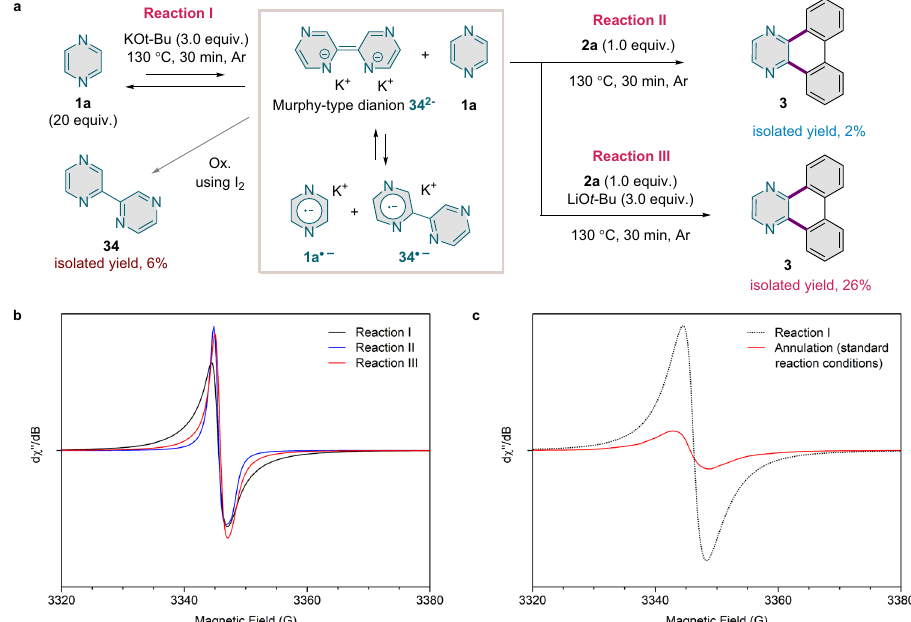
Fig. 4 EPR spectroscopic studies. a Experiments illustrating the dual role of KO t -Bu. b EPR spectra (X-band, 295 K) of samples from the reaction of 1a with KO t -Bu (reaction I; solid black line), from the two-step reaction of 1a with KO t -Bu and then with 2a (reaction II; solid blue line), and from the two-step reaction of 1a with KO t -Bu and then with 2a and LiO t -Bu (reaction III; solid red line). c EPR spectra (X-band, 295 K) of samples from the reaction of 1a with KO t -Bu (reaction I; dotted black line) and from the annulation of 1a with KO t -Bu and 2a (solid red line), with sample transfer conducted in an Ar atmosphere in both cases. The spectrum of the annulation was acquired using a microwave power one hundred times that used for the spectrum of the 1a – KO t -Bu